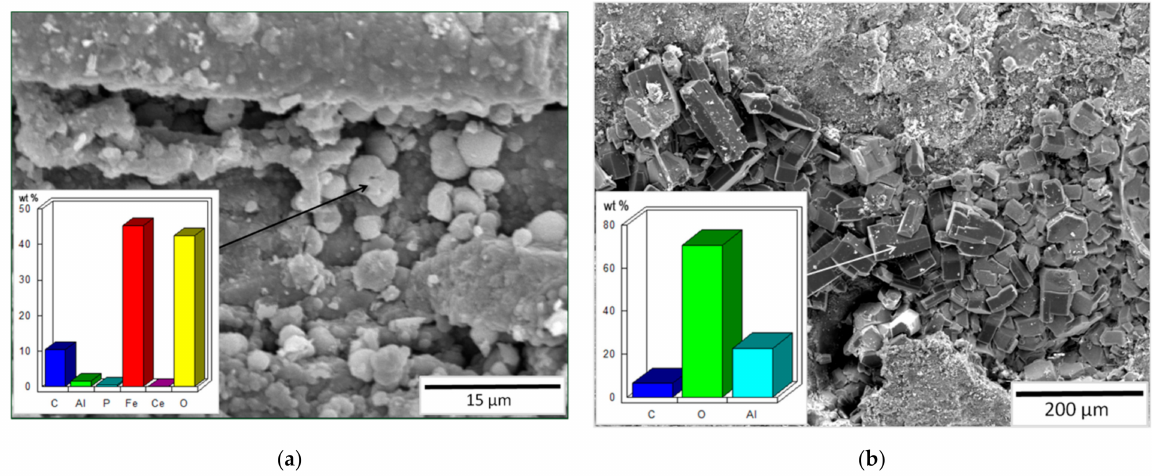
Figure 2. SEM images: goethite biomorphosis by wood and bacteria ( a ), druses of gibbsite crystals in mineralized plant roots ( b ).